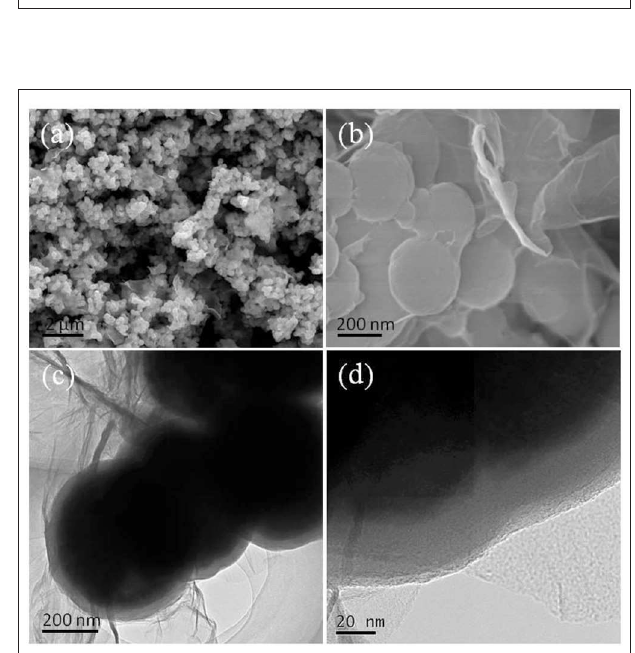
FIGURE 2 | (a) SEM image of Fe 3 O 4 @GO-c, (b) magnified SEM image of (a) , (c) TEM image of Fe 3 O 4 @GO-c, and (d) magnified image of (c)